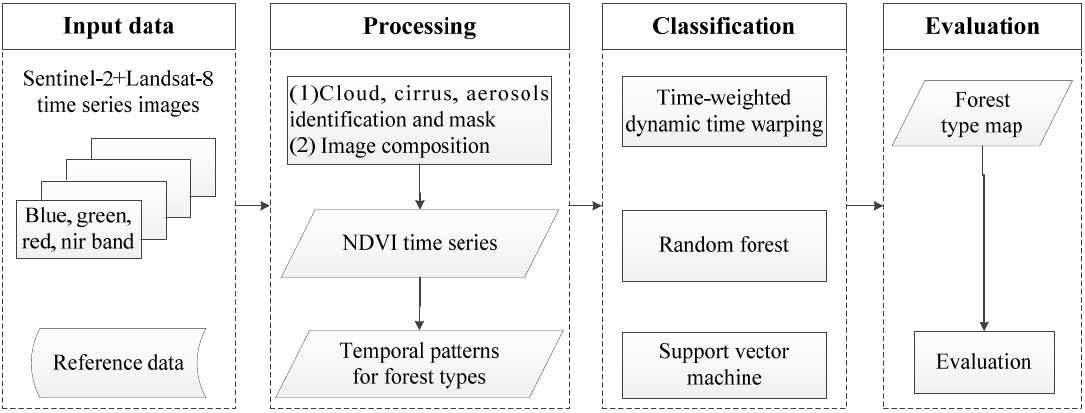
Figure 2. The workflow of TWDTW, RF, and SVM methods for forest type classification.